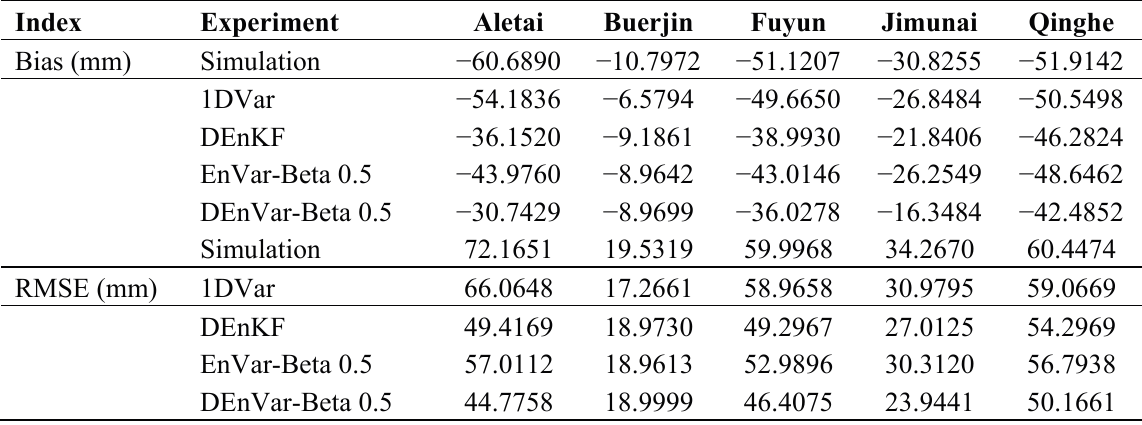
Table 4. Summary of the analyzed SWE statistics. Cf . Table